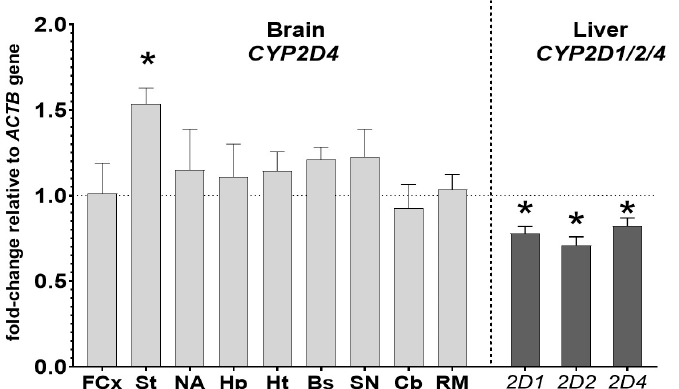
Figure 4. The influence of two-week treatment with iloperidone on the mRNA levels of the CYP2D4 gene in the selected brain structures and on the mRNA levels of the CYP2D1 , CYP2D2 and